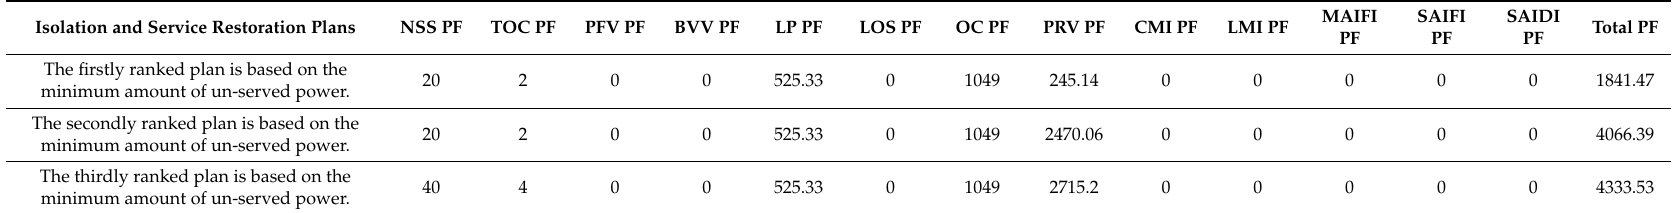
Table 14. Performance factors (PF) of the FLISR approach with respect to SPGF at